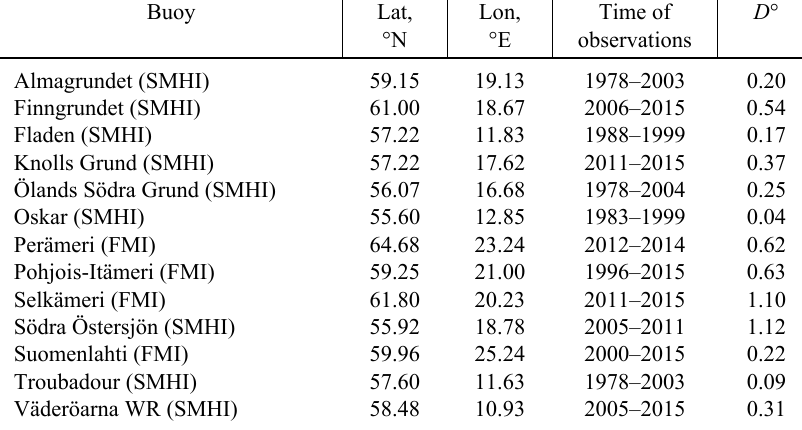
Table 2. The geographical coordinates, time intervals and distance from the land D of observations at the measurement sites, the data of which are used in this paper. Note that at Almagrundet the measurements were performed using an upward-looking echosounder attached to the seabed in about 30 m deep area (Broman et al. 2006) Buoy Lat, Lon, Time of °N °E